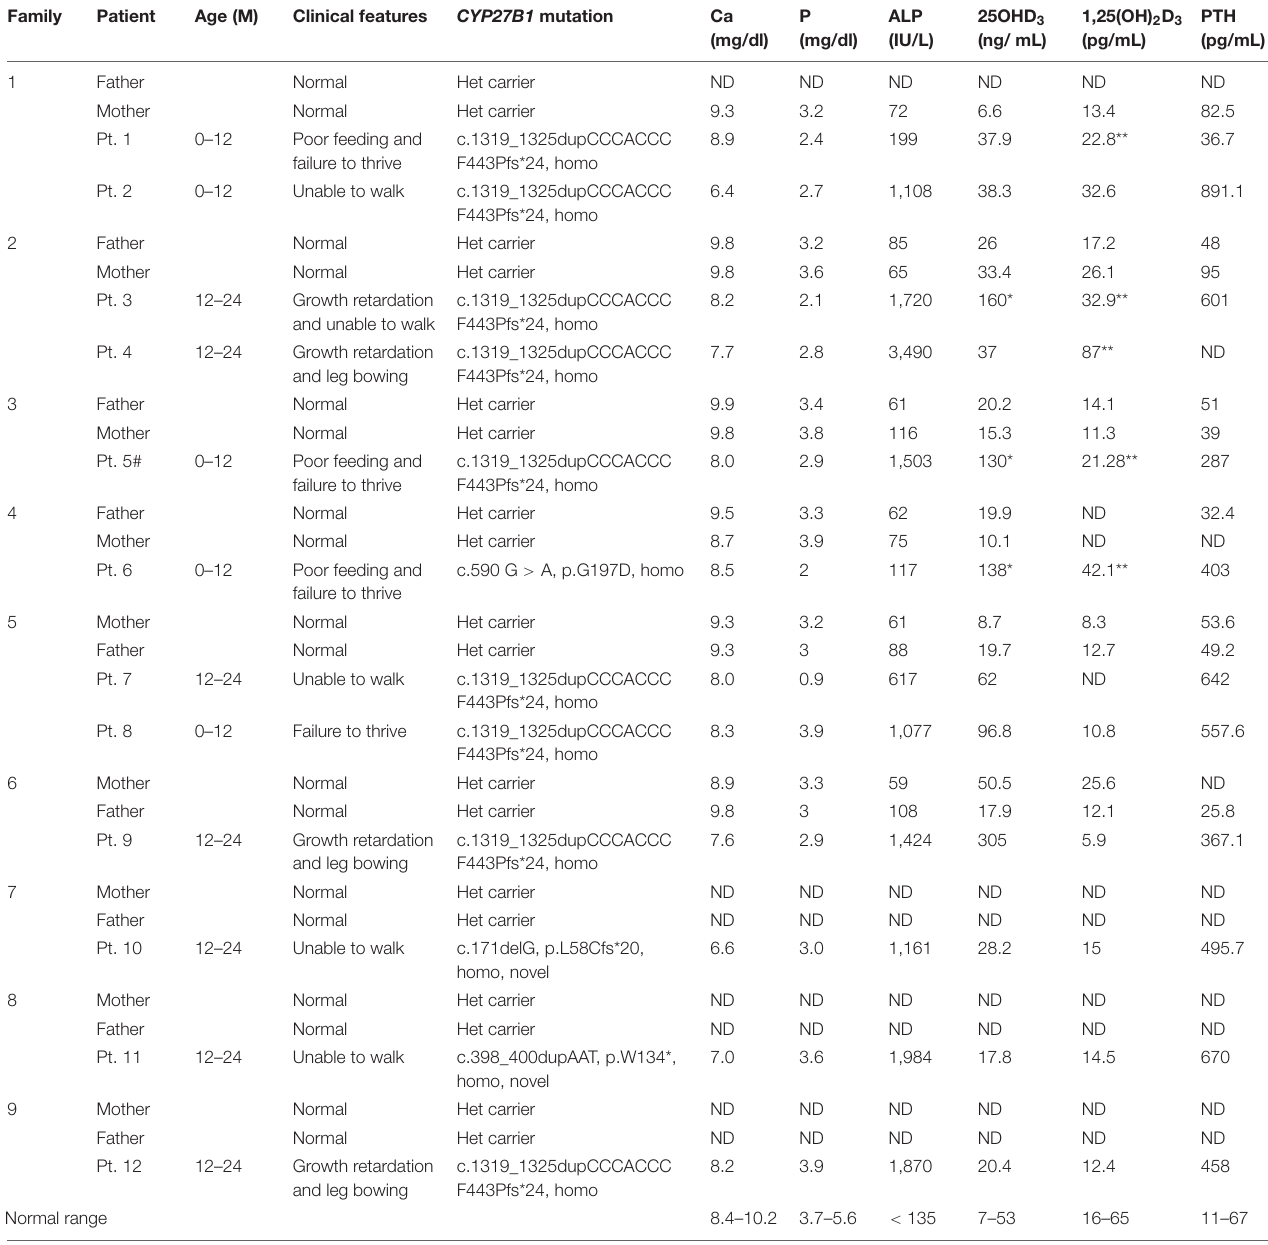
TABLE 1 | Clinical, laboratory, and genetic findings of patients with VDDR-1A rickets.